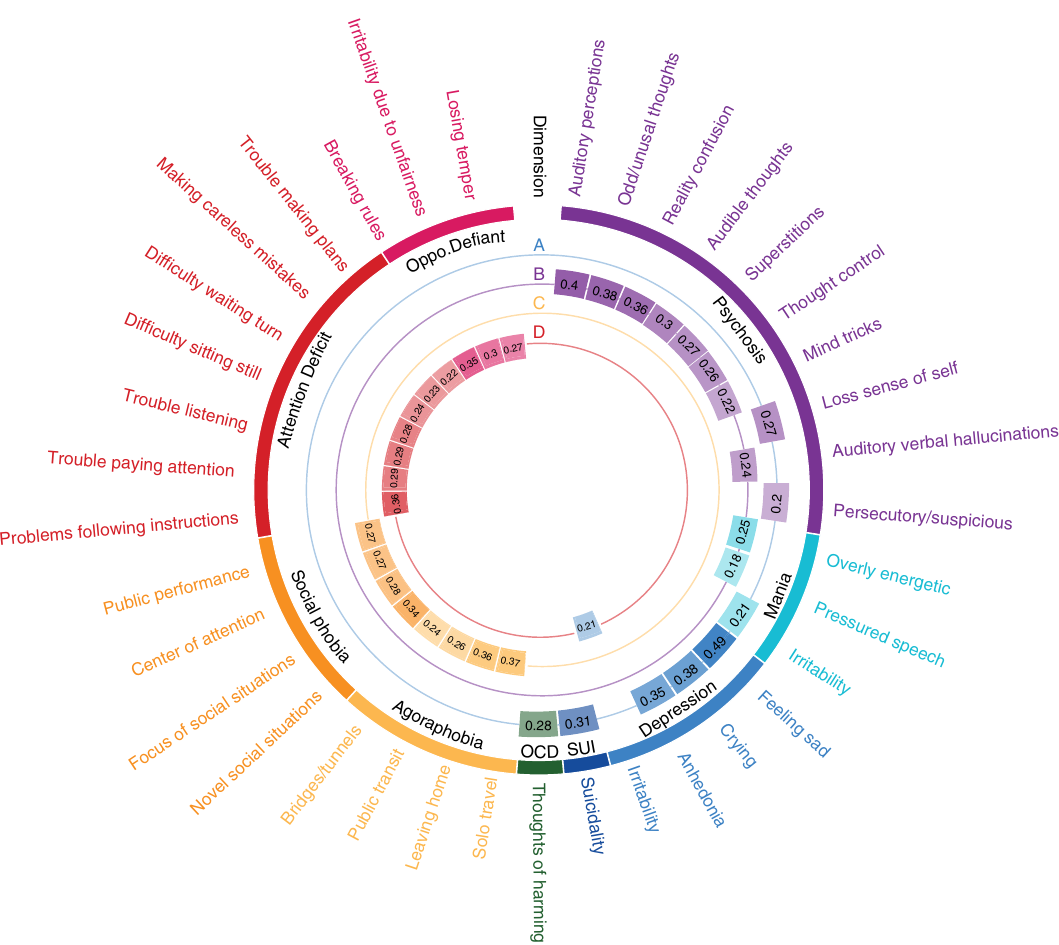
Fig. 4 Connectivity-informed dimensions of psychopathology cross clinical diagnostic categories. a The mood dimension was composed of a mixture of depressive symptoms, suicidality, irritability, and recurrent thoughts of self-harm. b The psychotic dimension was composed of psychosis-spectrum symptoms, as well as two manic symptoms. c The fear dimension was comprised of social phobia and agoraphobia symptoms. d The externalizing behavior dimension showed a mixture of symptoms from attention-de fi cit and oppositional de fi ant disorders, as well as irritability from the depression section. The outermost labels are the item-level psychiatric symptoms (see details in Supplementary Data 1). The color arcs represent categories from clinical screening interview and the Diagnostic and Statistical Manual of Mental Disorders (DSM). Numbers in the inner rings represent sCCA loadings for each symptom in their respective dimension. Only loadings determined to be statistically signi fi cant by a resampling procedure are shown